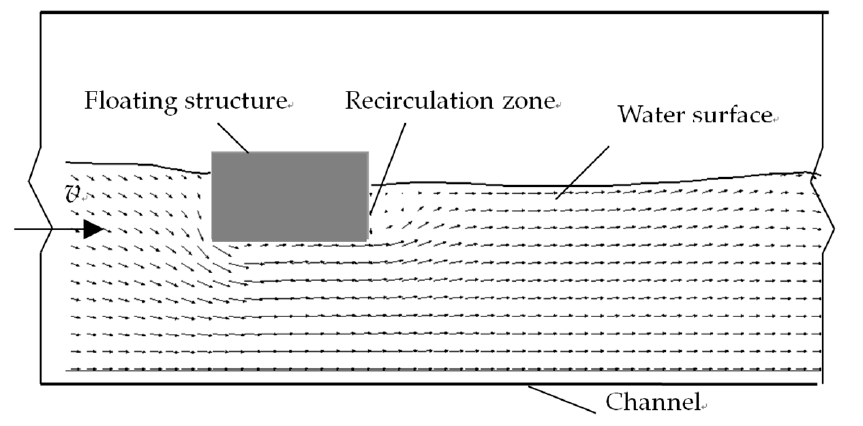
Figure 4. Schematic diagram of the flow.